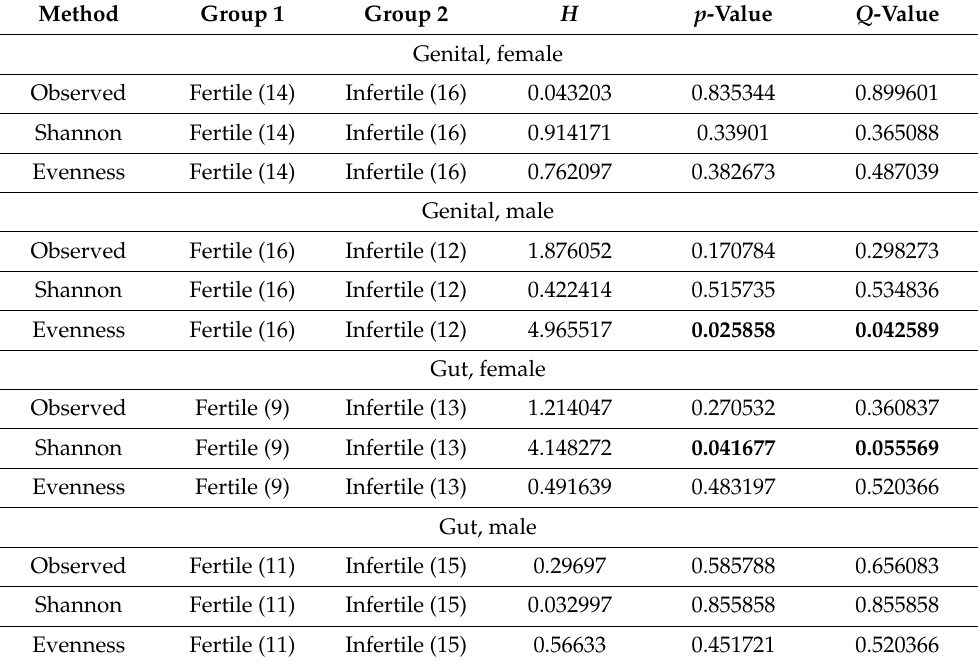
Table 5. Differences in the alpha-diversity of EC metagenome between samples. (<0.1 in bold).